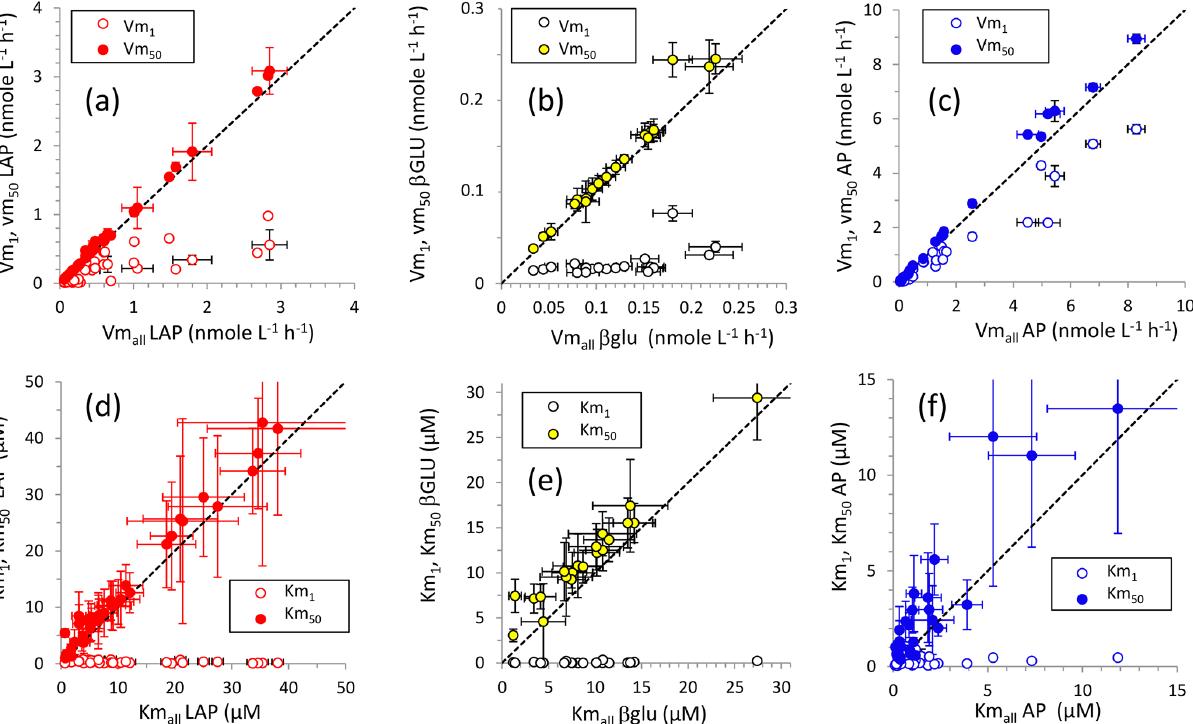
Figure 4. Relationships between kinetic parameters resulting from model 1, model 50 and the global model for the three ectoenzymes: (a, d) leucine aminopeptidase (LAP), (b, d) β -glucosidase ( β GLU) and (c, f) alkaline phosphatase (AP). (a, c, f) Relationships between Vm 1 and Vm all and between Vm 50 and Vm all ; (d, e, f) relationships between Km 1 and Km all and between Km 50 and Km all . Error bars show standard errors. The standard error in Km all in (d) , (e) and (f) (white dots) is not plotted for clarity.